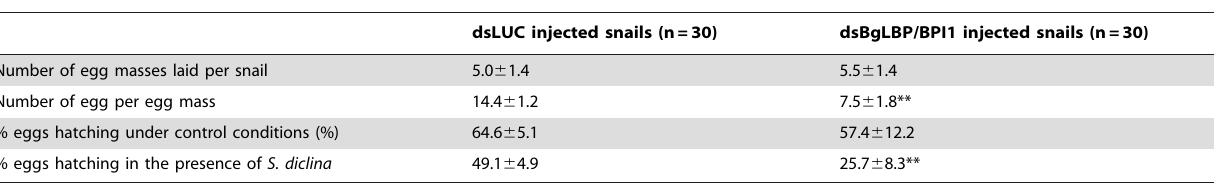
Table 1. BgLBP/BPI1 expression affects snail fecundity and egg survival to oomycete exposure.